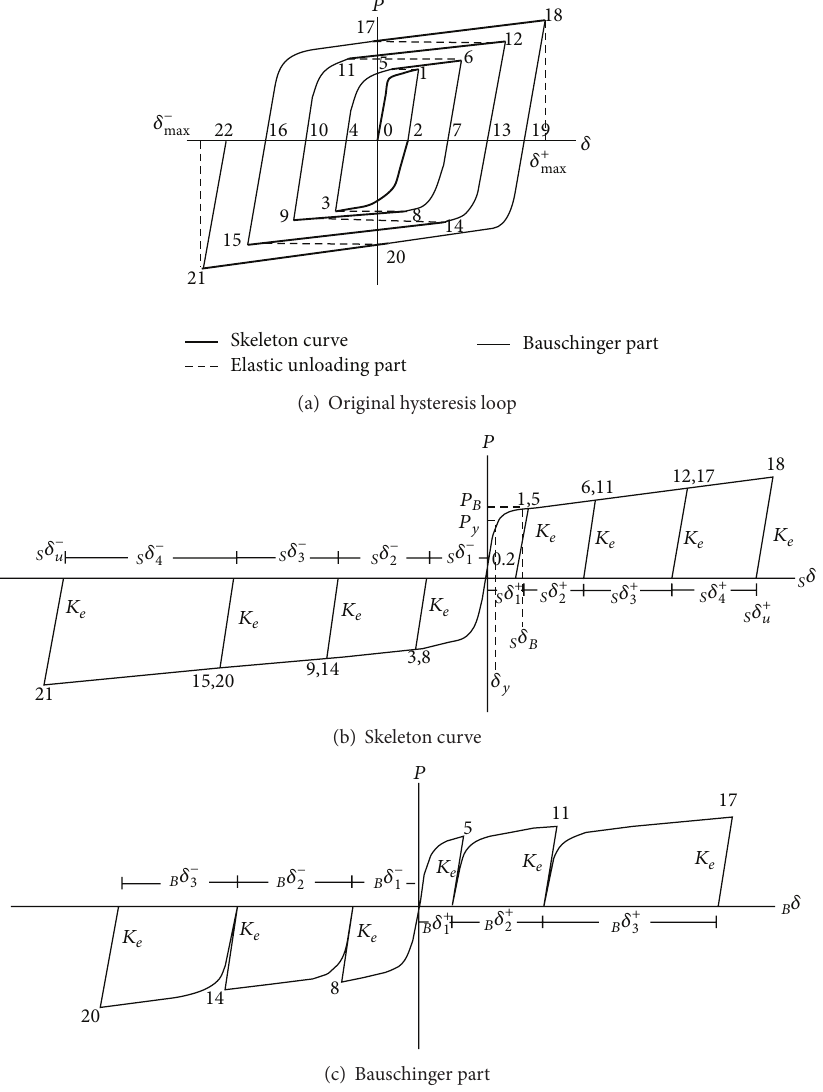
Figure 13: Decomposition of hysteresis